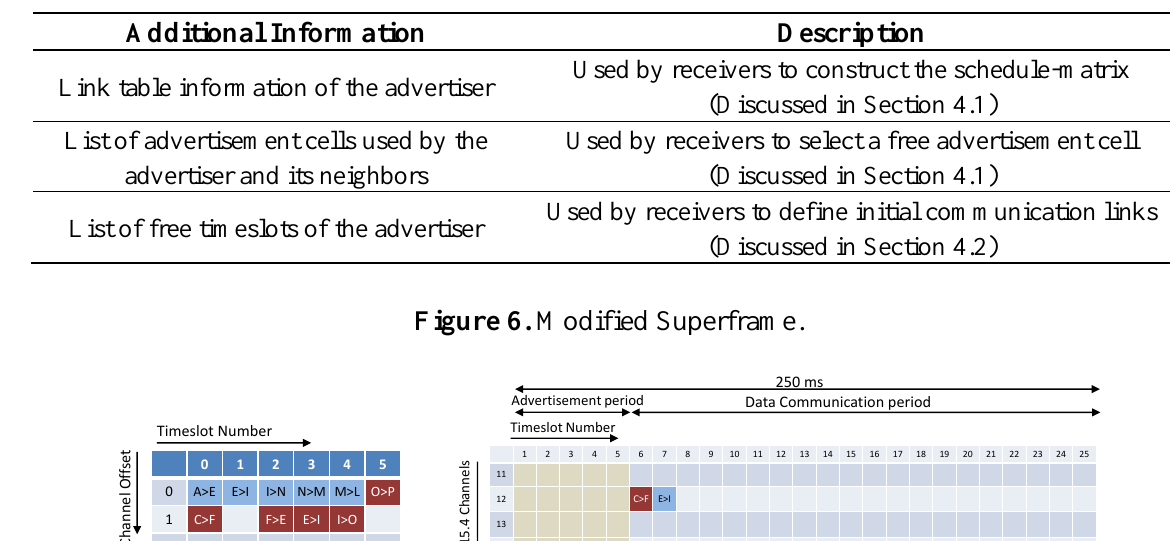
Table 2. List of additional information included in the advertisement payload.